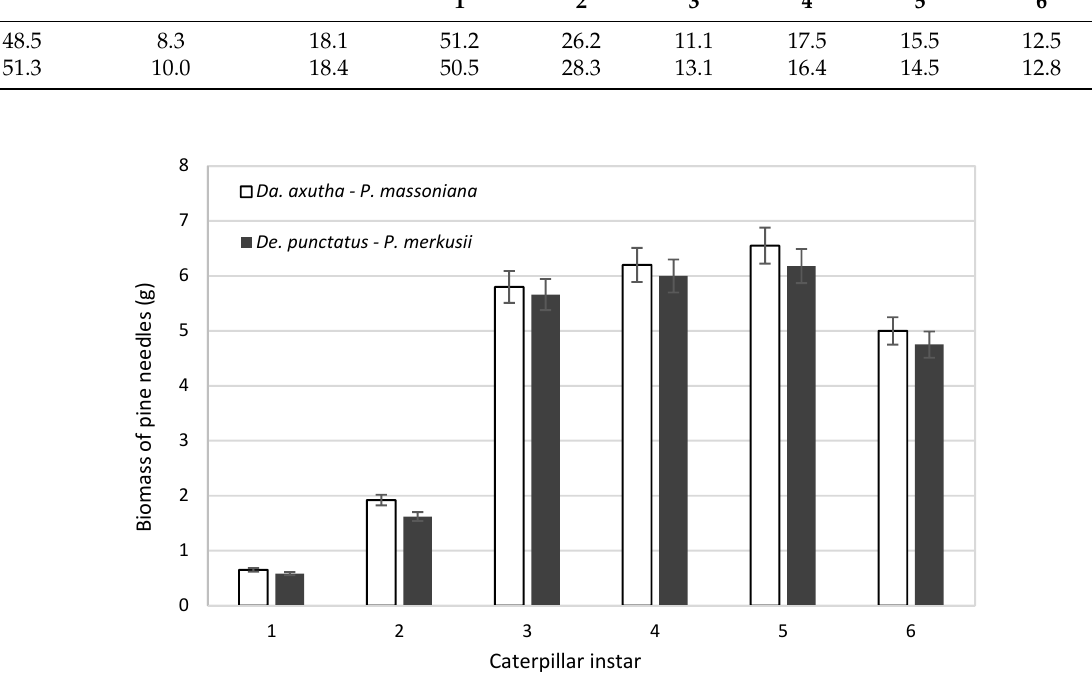
Figure 2. Biomass of pine needles (g) consumed per caterpillar in 24 h in the laboratory. The small vertical bars are +/ − SE (n = 30). Table 5. Theoretical fresh leaf biomass for pine species by average diameter at breast height. Amount of Fresh Leaf Biomass (kg) by Host Plant Species Average Dbh (cm) Pinus